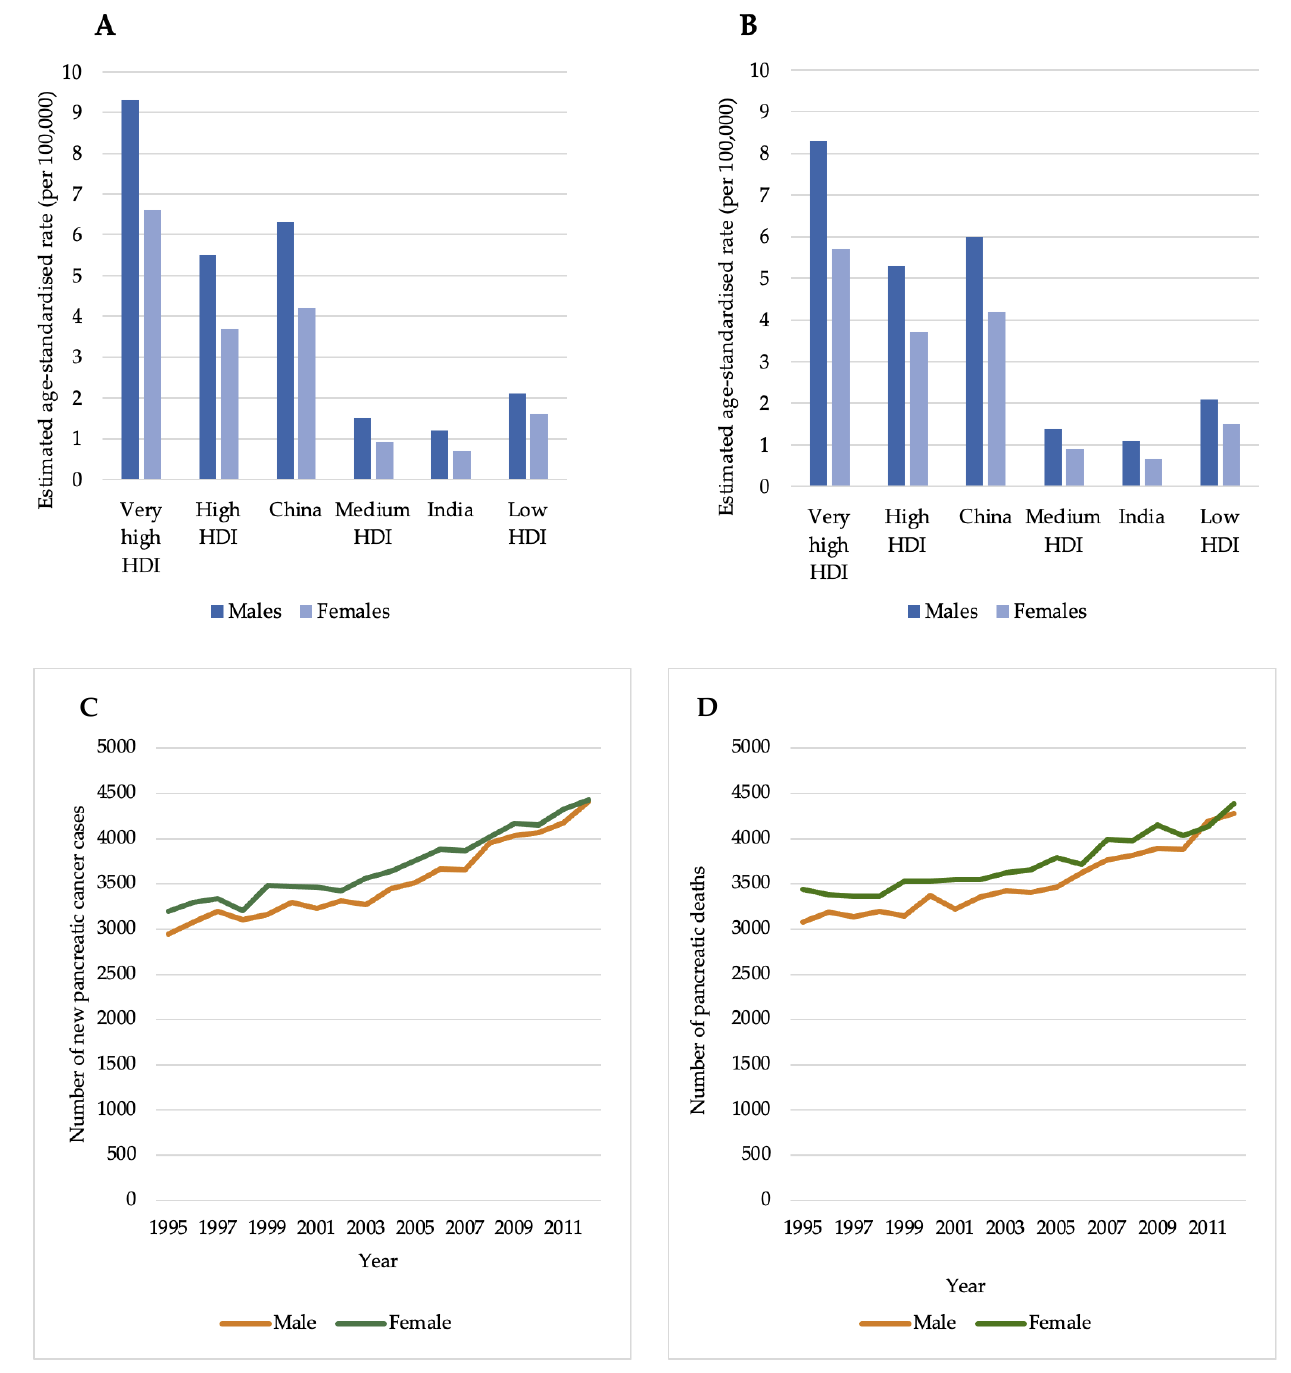
Figure 1. Estimated age-standardised (ASR) incidence ( A ) and mortality ( B ) rates for pancreatic cancer in 2020 to reflect international levels of education, social and economic development, using the four-tier Human Development Index (HDI) system, and trends in the estimated number of cases ( C ) and deaths ( D ) of pancreatic cancer in the United Kingdom between the years 1995 and 2012 in males and females of all ages (0–85+) Adapted from: GLOBOCAN, 2020 [17,20].